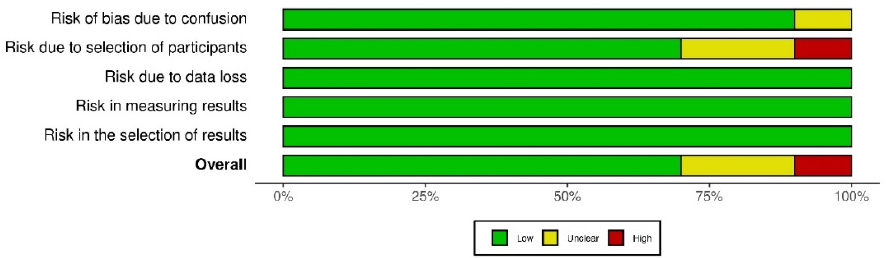
Figure 3. Risk of bias according to each domain and overall risk of bias.